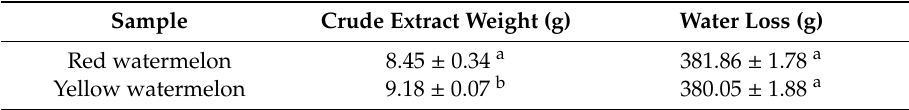
Table 2. Yield and water loss of the watermelon water extracts presented as means ± standard deviation from six replicates. The di ff erent letters (a and b) within the column indicate significant di ff erence ( p < 0.05) between the two